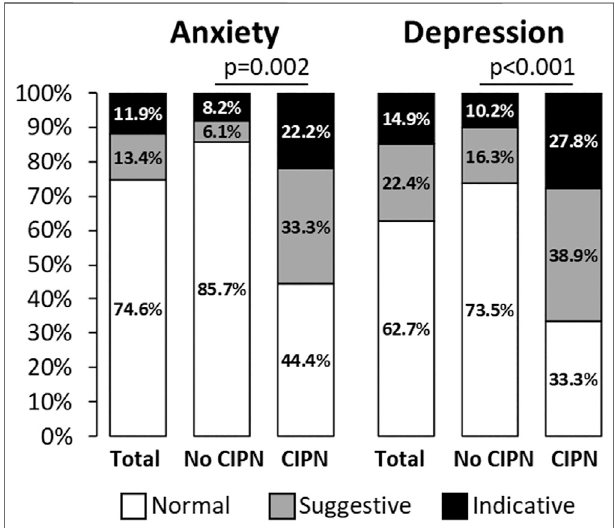
( Table 3 ). Most of the patients both in the sensory CIPN and neuropathic pain groups, declared to take paracetamol (75.0 and 62.5%, respectively), which was also similar to patients without sensory CIPN or neuropathic pain. No patient received duloxetine, one patient with a sensory CIPN received gabapentin and another one pregabalin. It is noteworthy that two patients without sensory CIPN took pregabalin